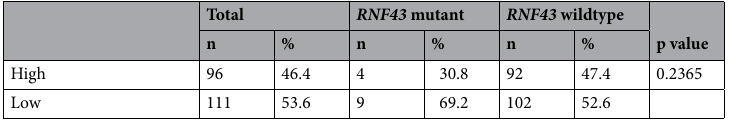
Table 3. Correlation of RNF43 mutation with clinico-pathological parameters in colorectal carcinoma. *Significant p value.